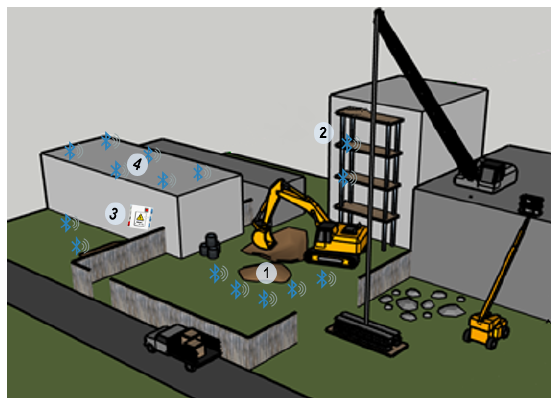
Figure 8. Usage scenarios in a construction site.